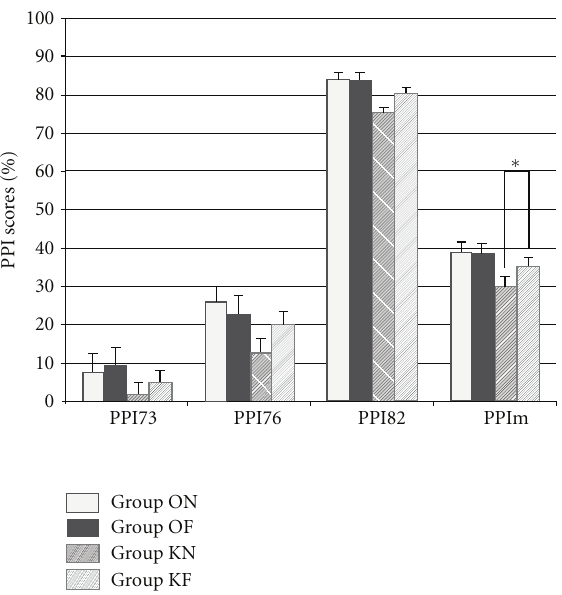
Figure 2: PPI scores (%) at PND56. All PPI mean scores are lower in group KN than in control groups (ON and OF). PPI mean scores in group KF tend to be intermediate between control groups (ON and OF) and group KN. ∗ P < 0 .